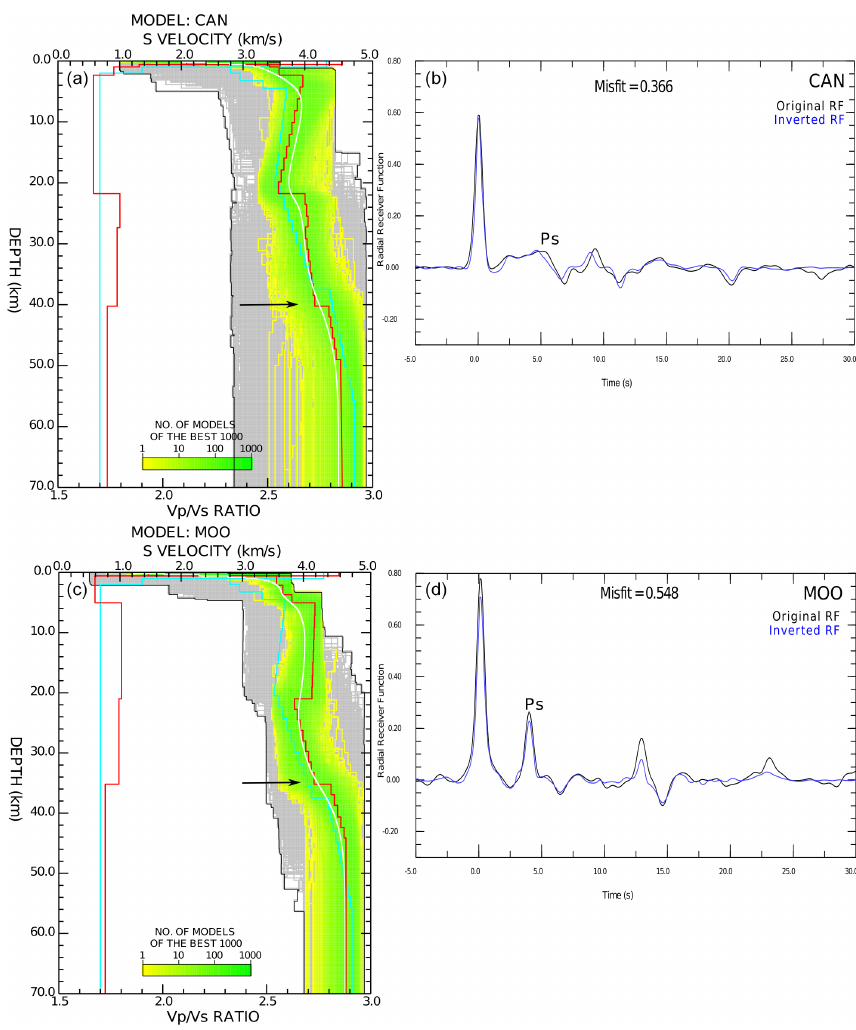
Figure 7. (a, c) Seismic velocity models for the CAN and MOO stations obtained from the neighbourhood algorithm (Sambridge, 1999a). The grey area indicates all the models searched by the algorithm. The best 1000 models are indicated by the yellow to green colours; the best model (smallest misfit) is shown using the red line, for both the S -wave velocity (top x axis) and V p /V s ratio (bottom x axis), and the white line is the average velocity model. Small black arrows denote the estimated depth of the Moho. (b, d) Waveform matches between the observed stacked receiver functions (black) and predictions (blue) based on the best models. “Misfit” refers to the chi-square estimate as defined by Eq.